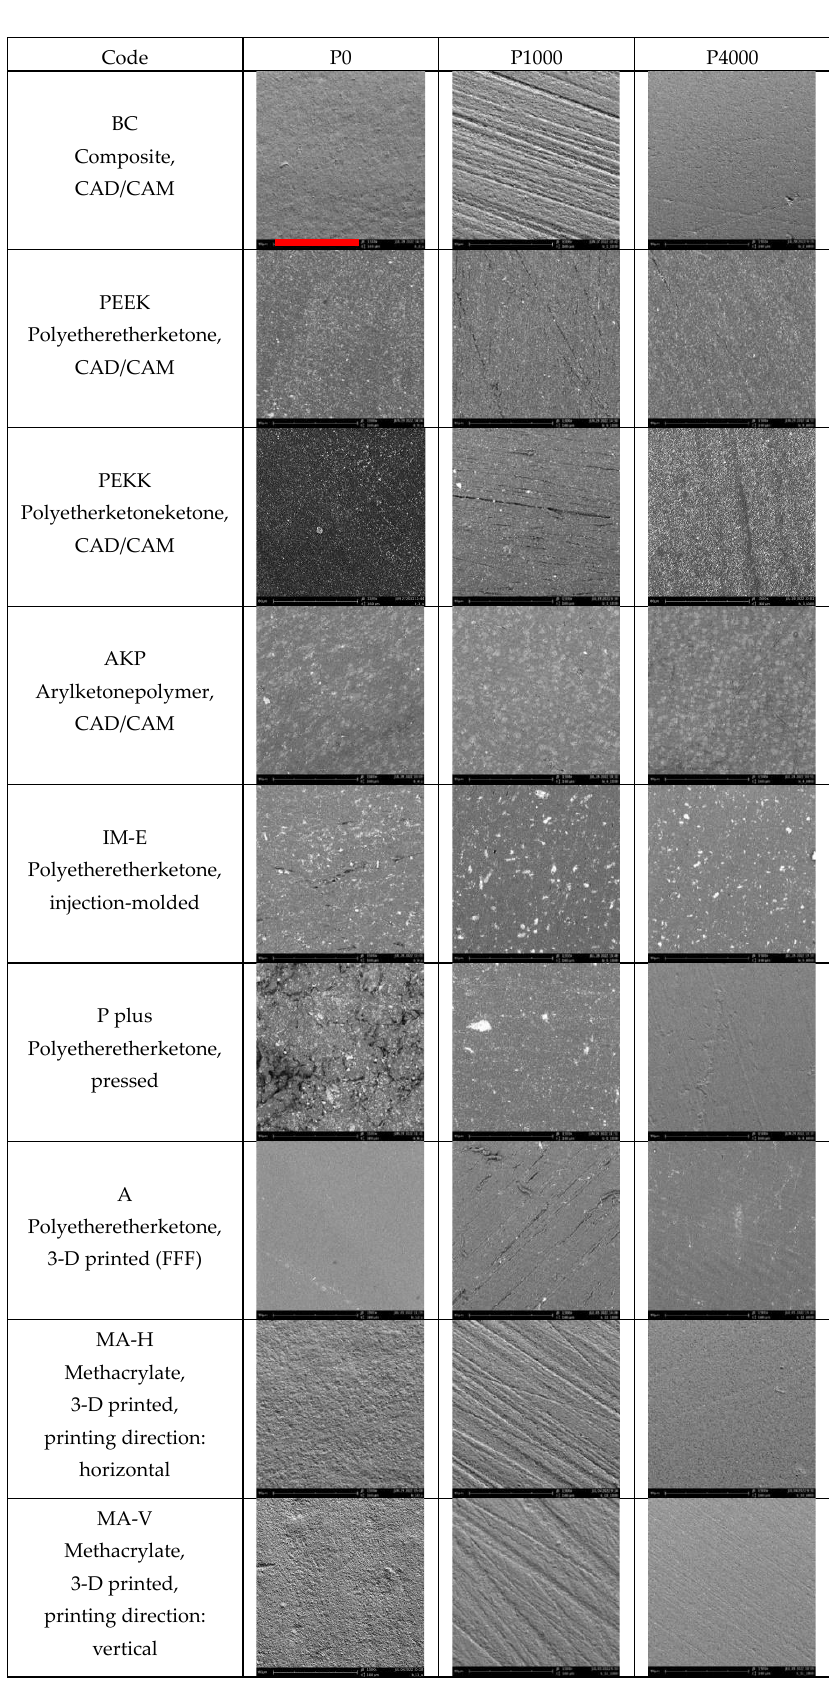
Figure 2. SEM-images, magnification 1500× (red bar: 80 µm valid for every figure).